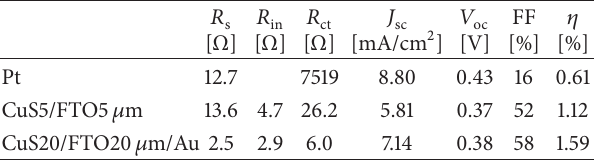
Table 1: Resistance values and solar cell